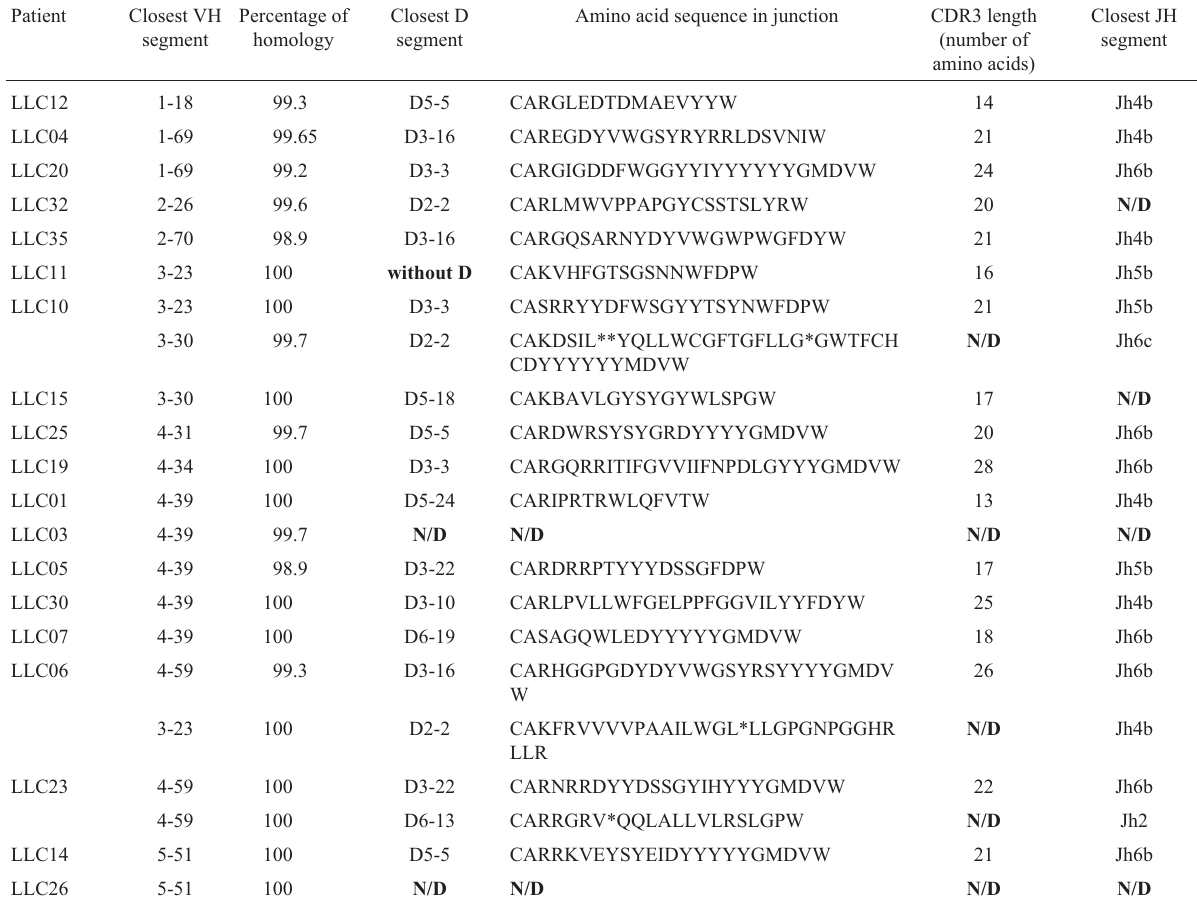
Table 1 - VH-D-JH rearrangements in the 19 unmutated Brazilian CLL